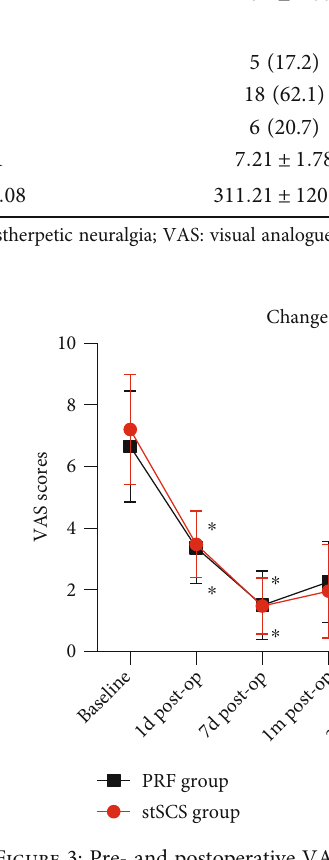
Figure 2: Postoperative e ff ective rate. ∗ P < 0 : 05 indicates the PRF group vs. stSCS